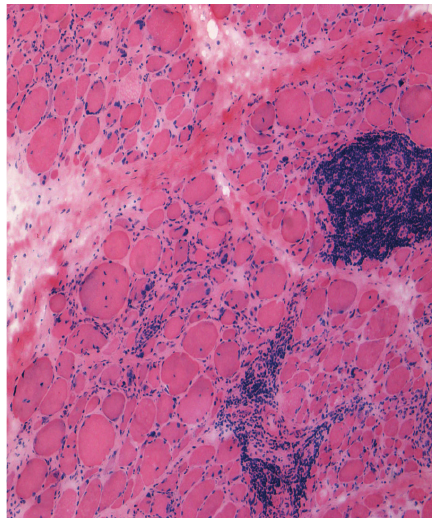
Figure 2: Muscle biopsy demonstrating gross lymphocyte